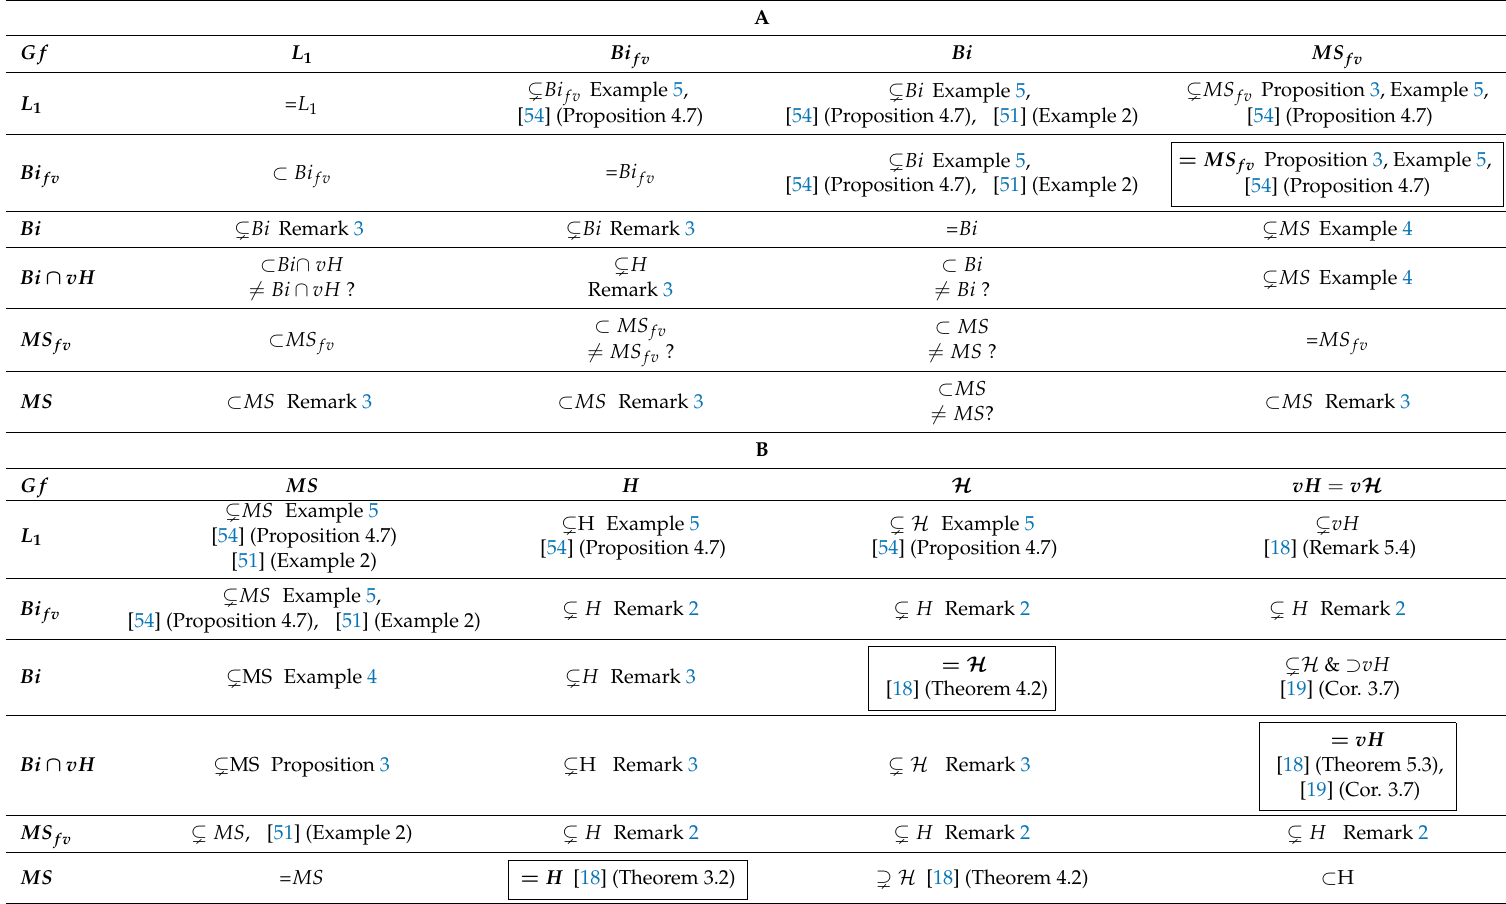
Table 2. Part A : Decomposition : Γ = G + f , arbitrary gauge defined G and f . Part B : Decomposition: Γ = G + f , arbitrary gauge defined G and f